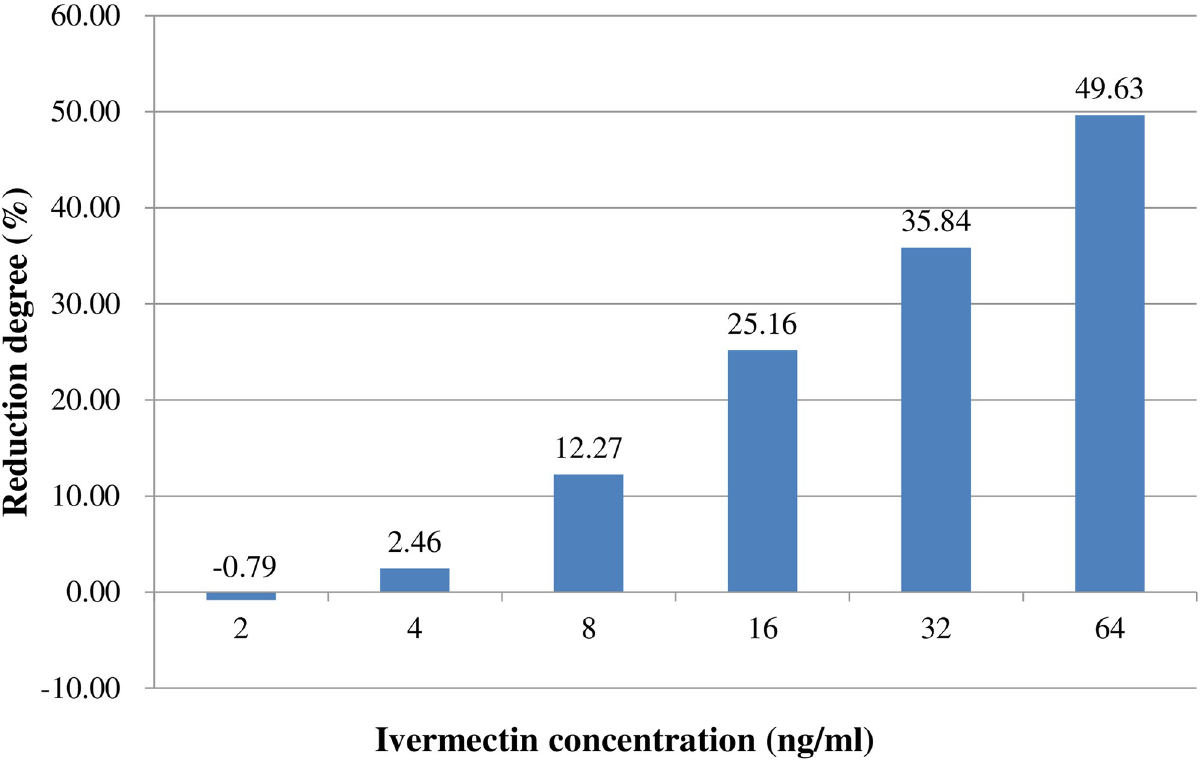
Fig 1. Compared to mosquitoes fed with 0ng/ml ivermectin, the reduction degree of infection rate for each treatment group. The calculation formula is as follows: (infection rate in mosquitoes fed with 0ng/ml ivermectin-infection rate in each treatment group)/ infection rate in mosquitoes fed with 0ng/ml ivermectin �